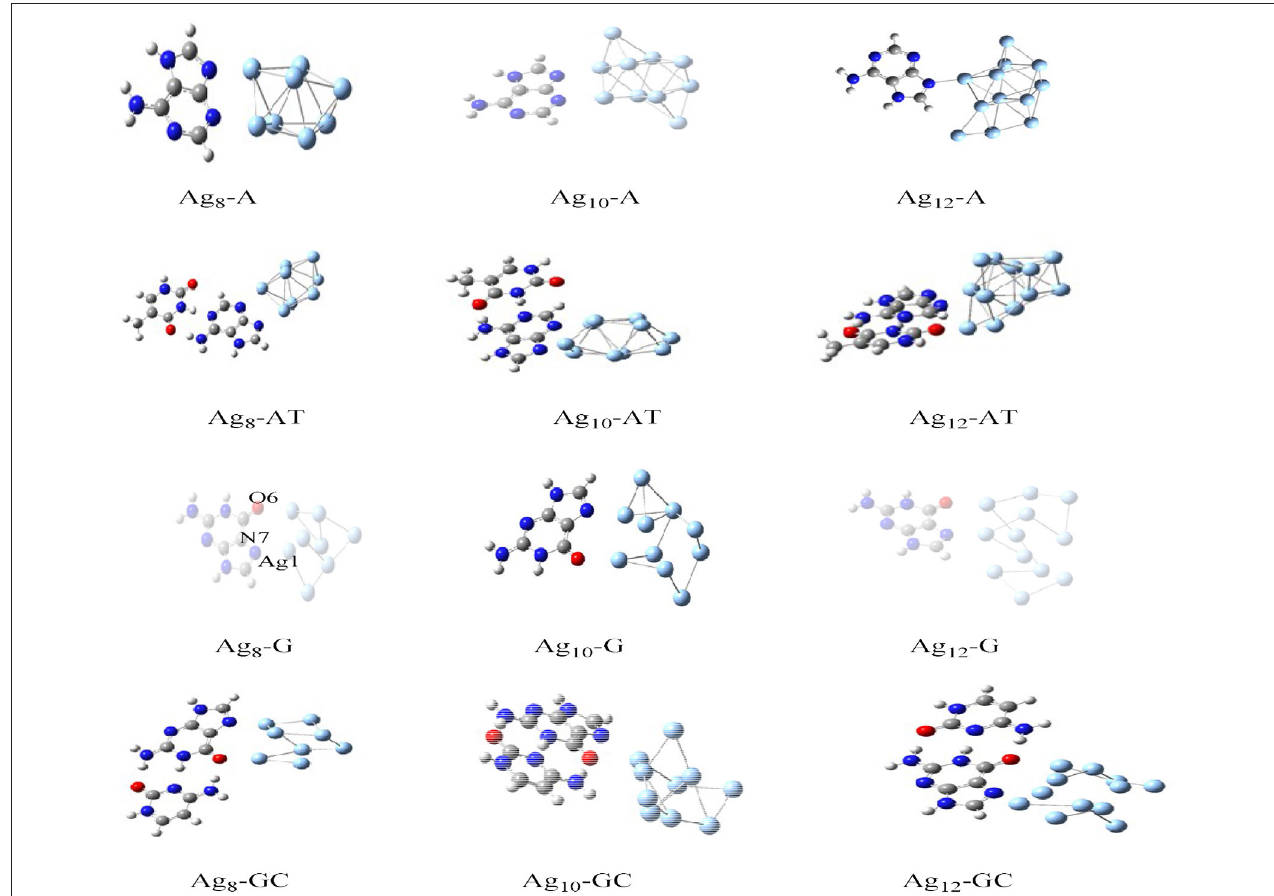
FIGURE 5 | Optimized structures of Ag 8 -A, AT, G, and GC base pairs (Adapted with permission from Taylor and